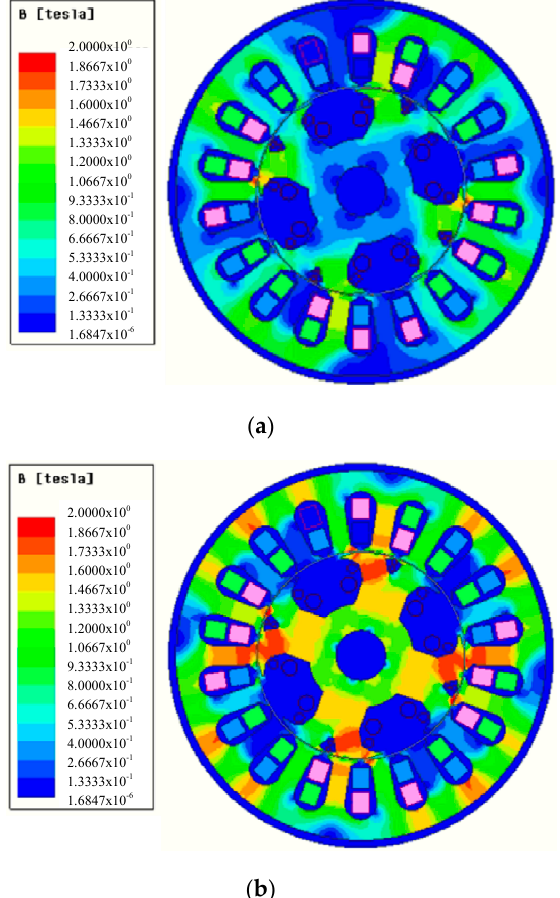
Figure 8. Magnetic flux density distribution plot of the machine at ( a ) 0.015 s and ( b ) 1.5 s.